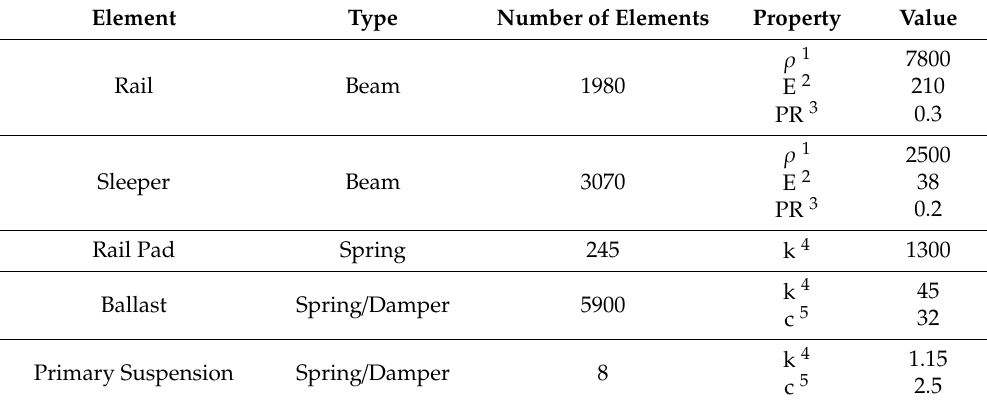
Table 1. Dynamic material properties used in the numerical